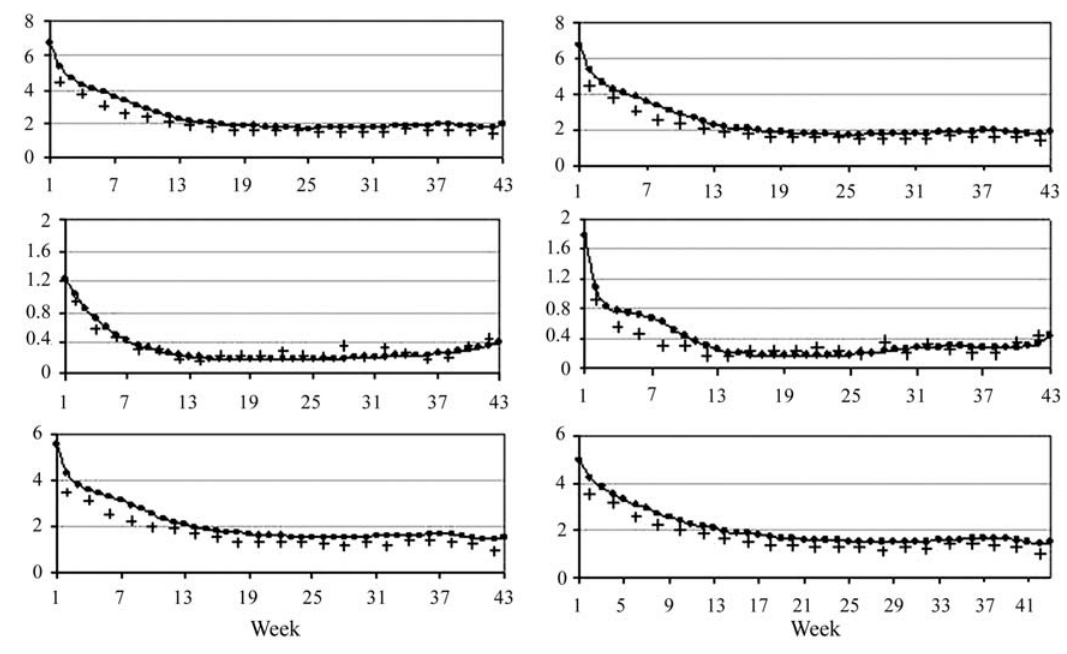
Figure 2 - Phenotypic (top), genetic (middle) and environmental (bottom) variance estimates from 4,6,vf6 (left) and 6,6,vf6 (right) random regression and standard univariate (+) analysis.